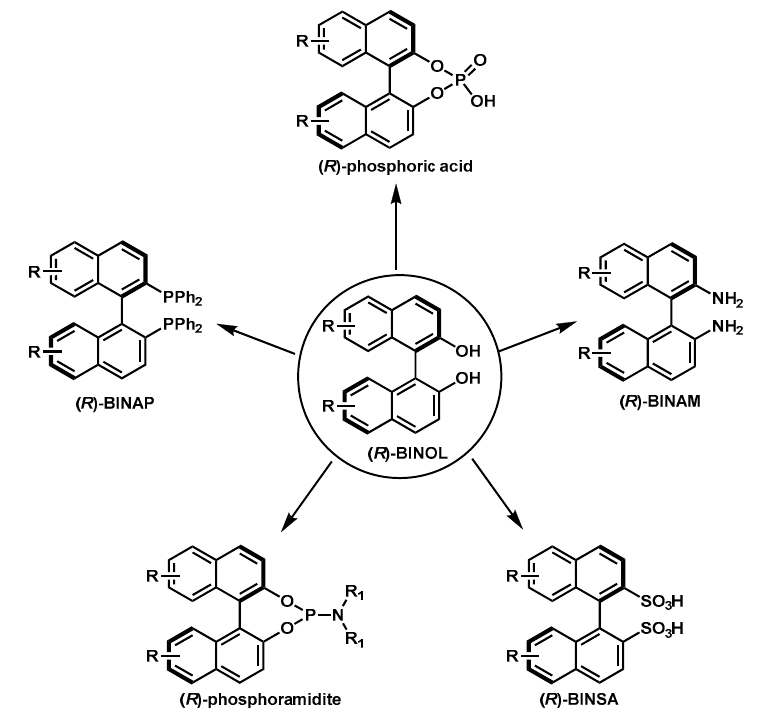
Figure 1. Representative 1,1 ′ -Bi-2-naphthol (BINOL)-derived ligands/catalysts.